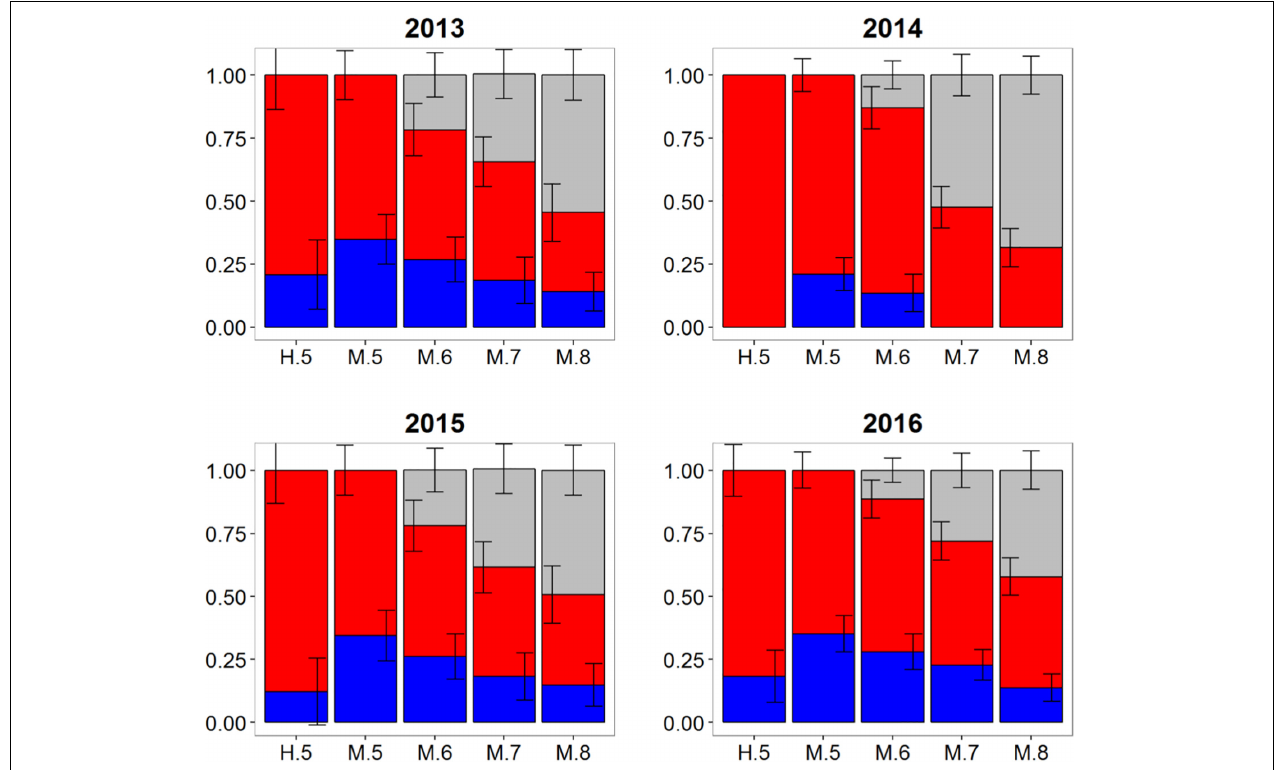
FIGURE 6 | Estimated proportions of western (blue), eastern (red), and undetermined (gray) Atlantic bluefin tuna in samples collected from 2013 to 2016 in the Canary Islands. Results are based on mixed-population analysis using HISEA and multinomial logistic regression (MLR) frameworks. H.5 denotes predictions from HISEA while MLR estimates are shown as M.5, M.6, M.7, M.8 to represent the four different probability thresholds (0.5–0.8). Uncertainty around predictions shown with error bars which represent 1 ± SD around estimated